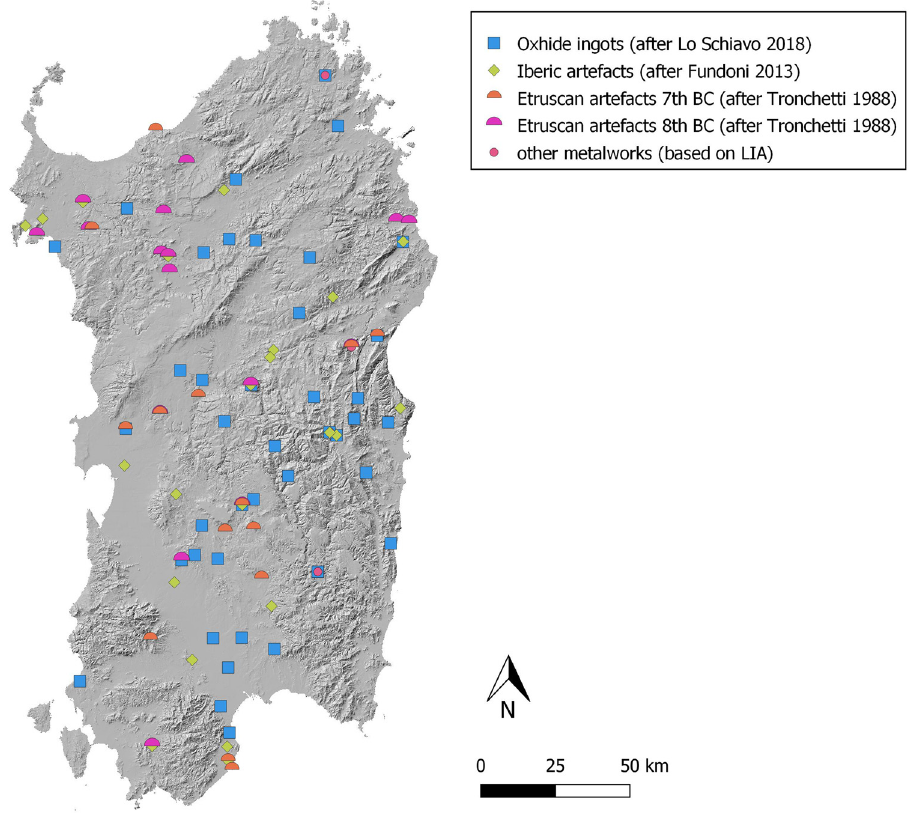
Figure 5: Foreign metal artefacts imported in Sardinia between the RBA and the EIA. The map shows the location in which oxhide ingots, Iberian - like weapons, and Etruscan fi bulae have been found on the island. Generally, objects have been discovered evenly all over the island, although there is a more signi fi cant distribution of Etruscan fi bulae on the north of Sardinia.